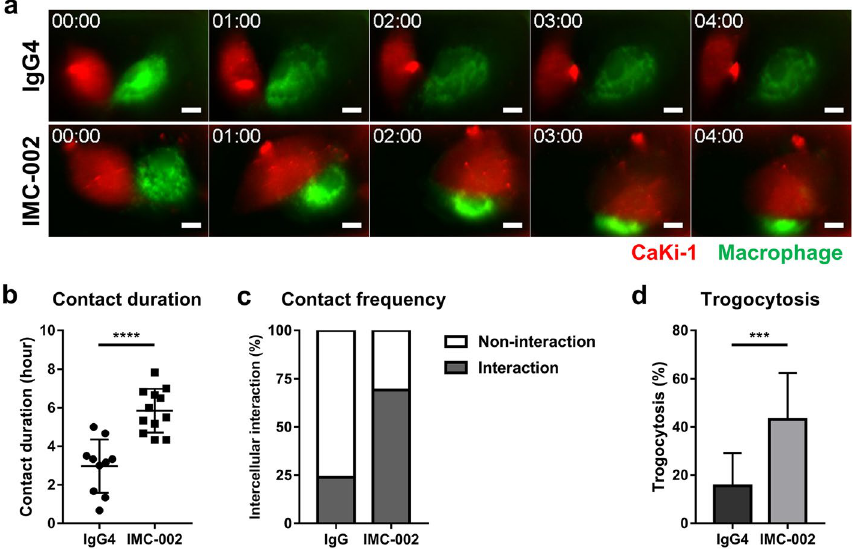
Figure 3. The interaction between macrophages and RCC cells is enhanced by CD47 blockade. ( a ) Snapshot of live-imaging videos (Supplementary Video 1). The Caki-1 cells (red) and macrophages (blue) were cocultured as a single cell in a microwell plate for 4 h. Each picture was taken at 1-h intervals from the start of the recording. Time displayed in the upper left of the images indicates the hour and the scale bar at the lower right represents 10 μm. ( b ) Contact duration time and ( c ) interaction frequencies of macrophages and Caki-1 cells quantified in live-imaging data. ( d ) Bar graph representing the quantified level of trogocytosis observed in the microwell